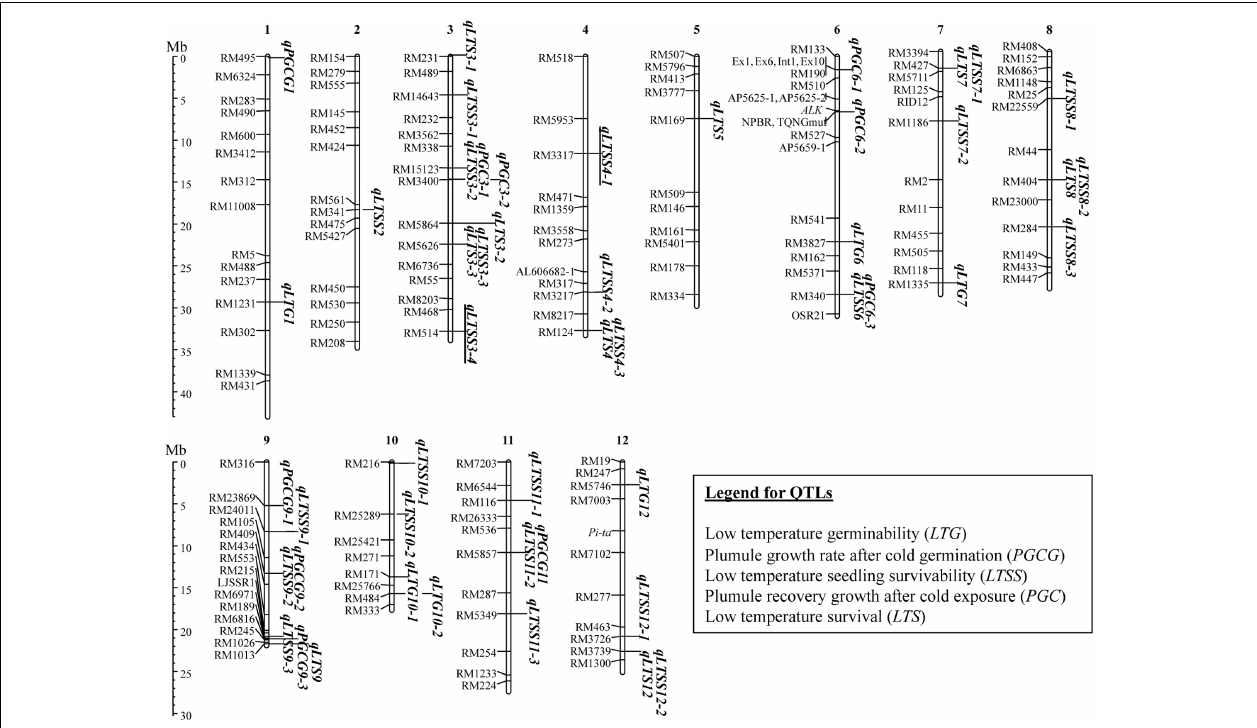
FIGURE 3 | Quantitative trait loci (QTL) locations based on genome wide association study (GWAS) mapping analysis using the rice mini-core collection (RMC) as reported in Table 3 . The QTL, qLTSS3-4 and qLTSS4-1 (underlined) are novel, whereas the other QTL overlap with or are within 1.5 Mb of previously published chilling tolerance QTL (Supplementary Table S2). Details of the individual QTL are in Table 3 . Markers are further described in Bryant et al. (2011), and the figure was created in MapChart (Voorrips,